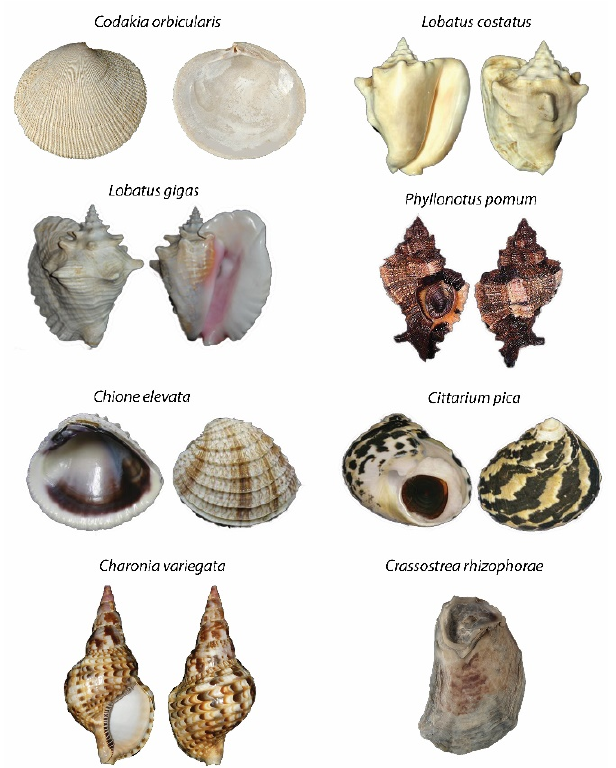
Figure 3. Most common mollusk shells registered on the research